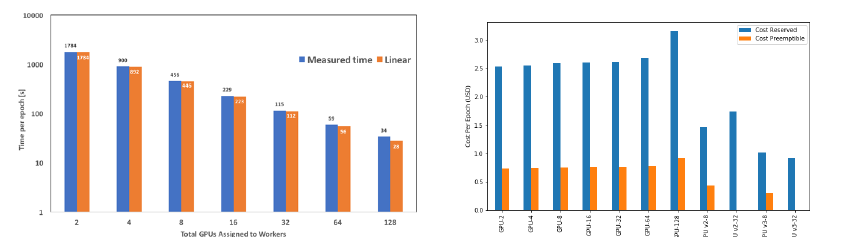
Figure 5. (left) The impact of increasing number of total GPUs assigned to workers on time to process one epoch of training. (right) Cost of running one epoch on the Google Cloud Platform. The cost per epoch remains similar for all GPU combinations, though the training time improves almost